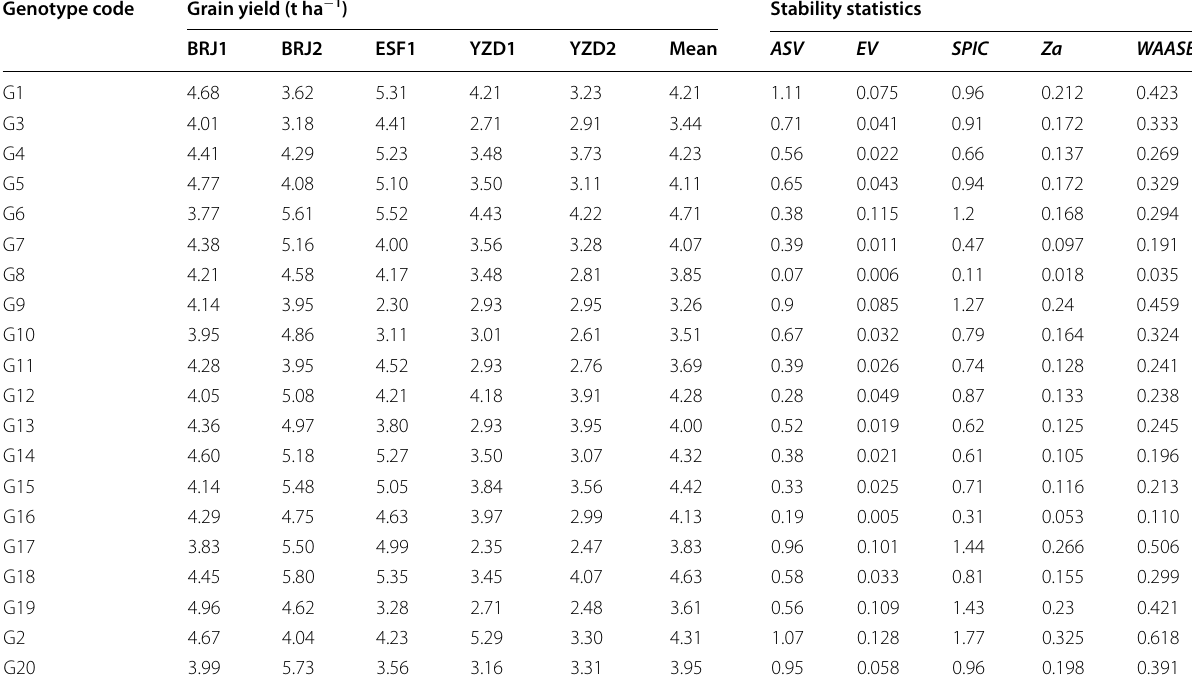
Table 4 Mean grain yield (t ha − 1 ) and several stability statistics of the 20 investigated barley genotypes across three saline regions of Iran Genotype